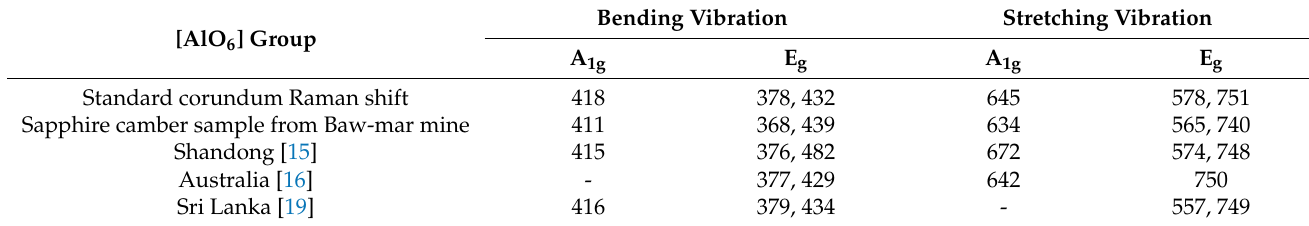
Table 4. Raman peak frequency and attribution of Sapphire. (cm − 1